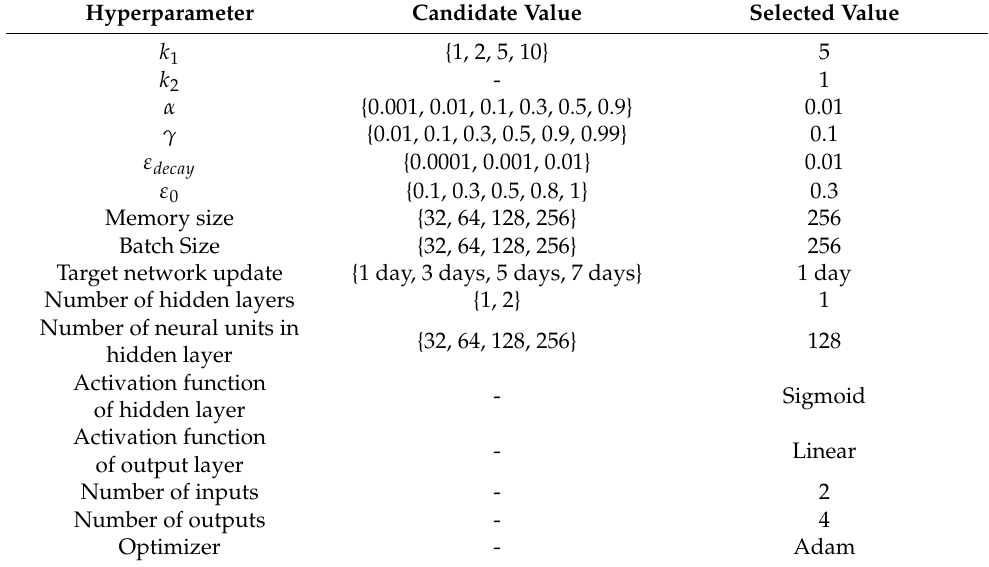
Table 3. Hyperparameter settings.